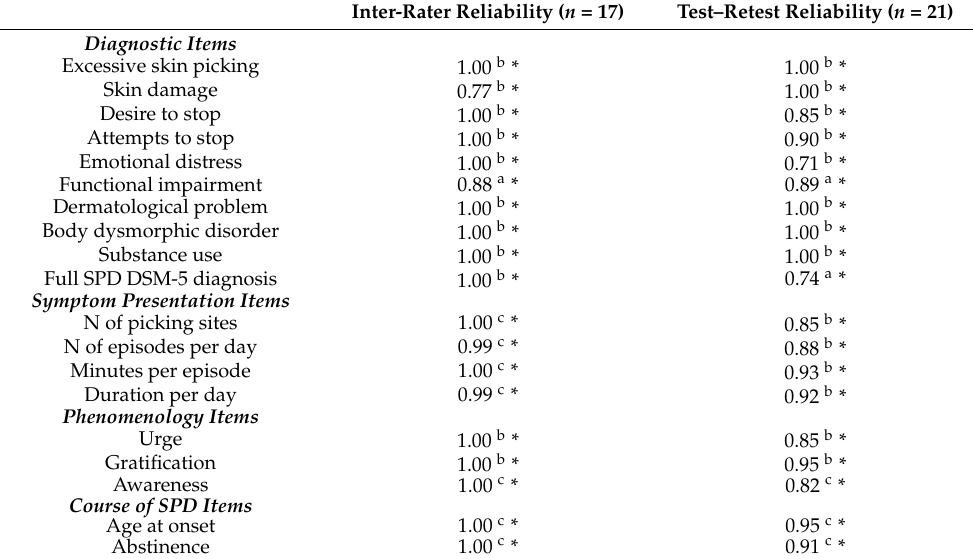
Table 3. Inter-rater and test–retest reliability.